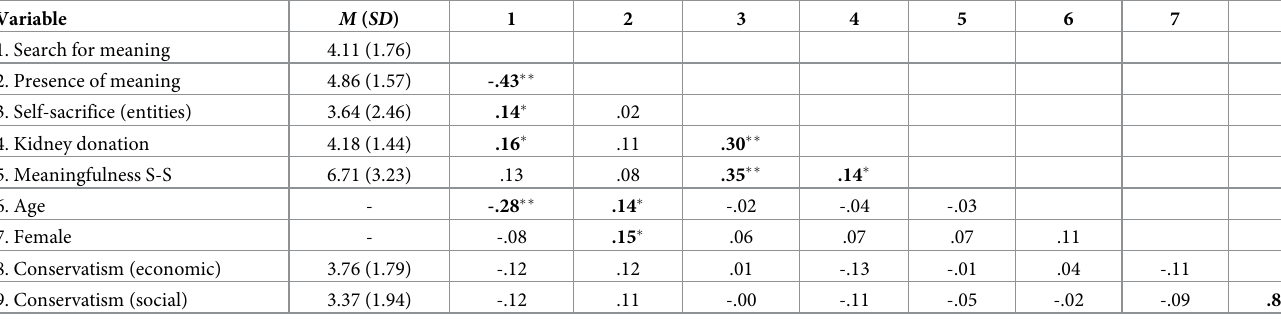
Table 1. Correlations matrix and descriptives in Study